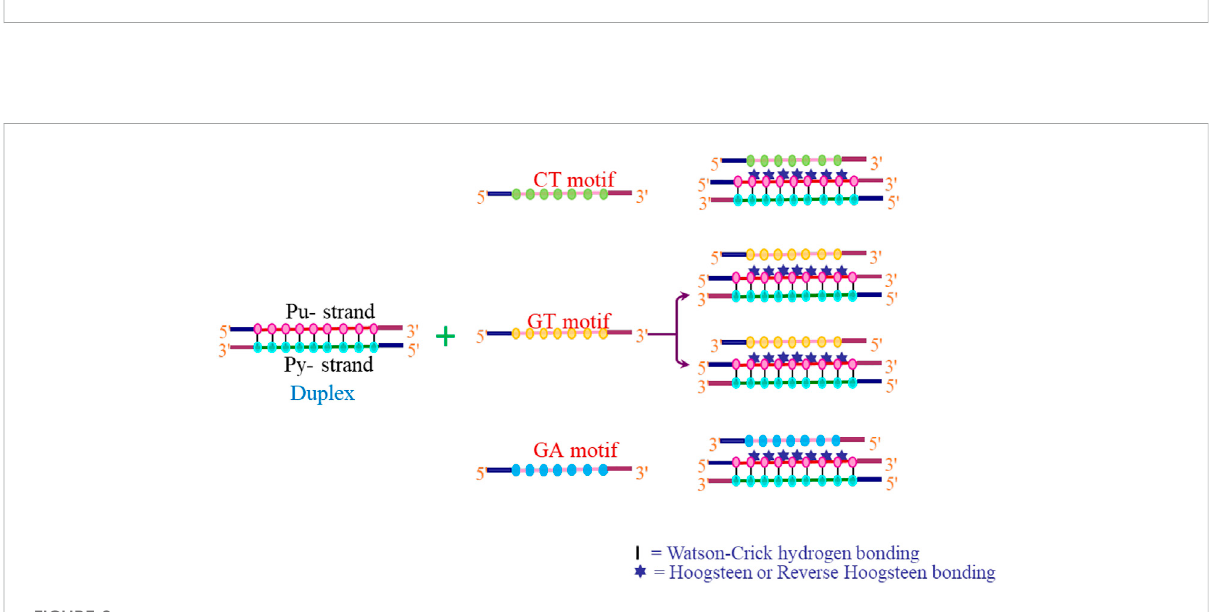
FIGURE 8 Possibilities of intermolecular triplex